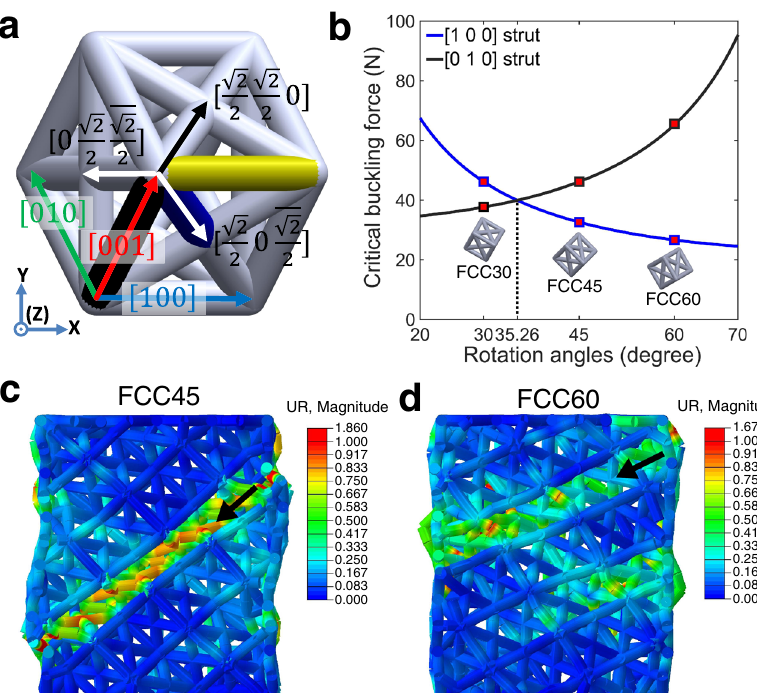
Fig. 2 Theoretical and fi nite element analysis. a Miller indices of individual struts where ½ 100 (cid:2) , ½ 010 (cid:2) and ½ 001 (cid:2) struts belong to a group of h 100 i struts, ffiffi ffiffi ffiffi ffiffi ffiffi ffiffi p p p p p p 2 2 2 2 2 2 while ½ 0 (cid:2) , ½ 0 (cid:2) and ½ 0 (cid:2) struts belong to the group of h 2 2 2 2 2 2 (effective length factor of strut) along the global Z axis. c , d Sectional views of FEA simulations parallel to ( X , Y ) plane for FCC45 and FCC60 at 14.5% strain, respectively, showing rotational displacement at deformed